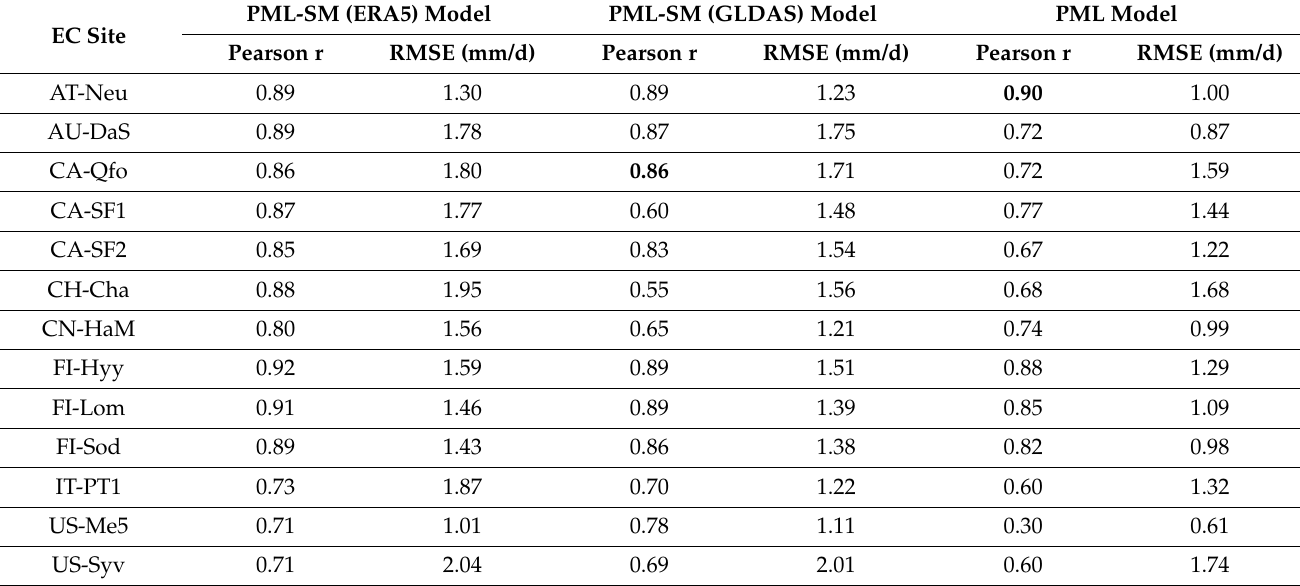
Table 2. Quantitative measures of the PML model, PML-SM model performance at daily time-steps for 13 EC